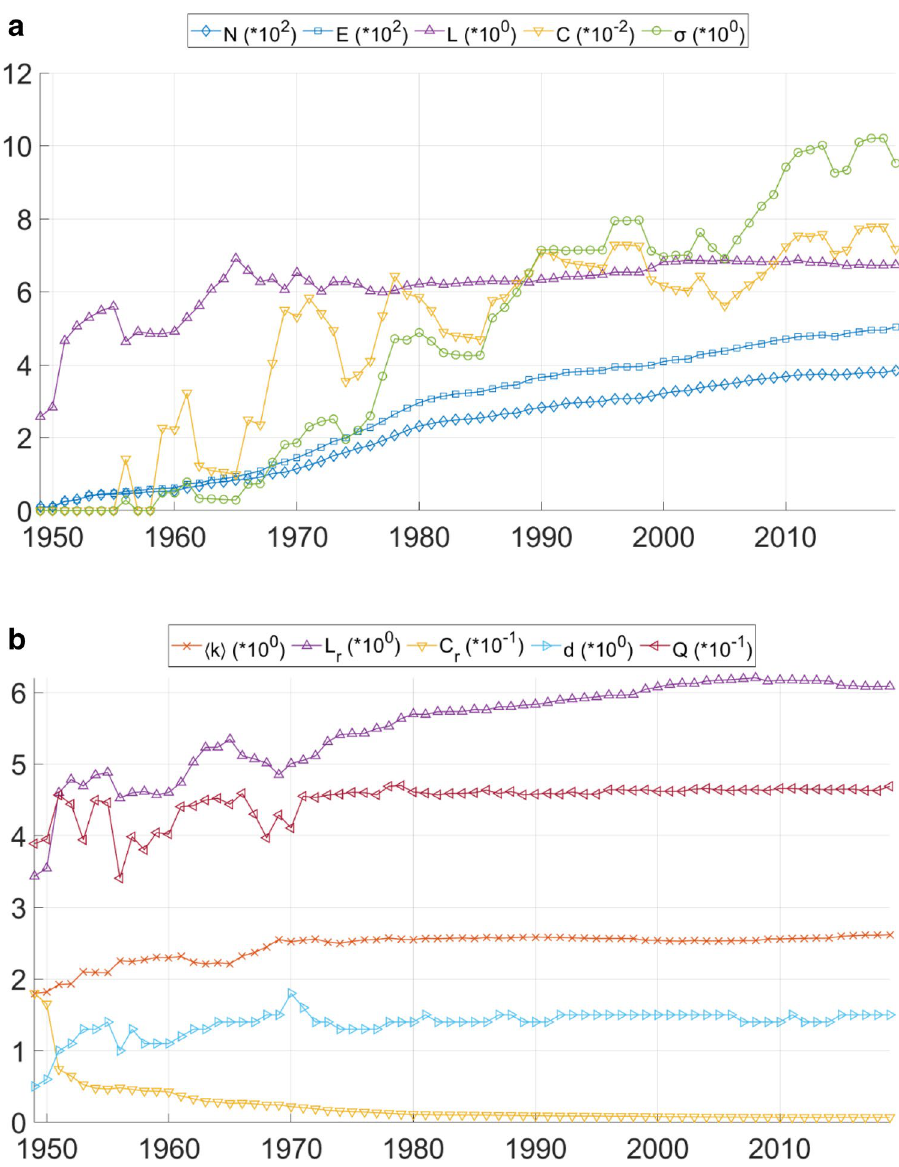
Figure 1. ( a ) Results of the long-term complex network analysis. N nodes, E edges , L average path length, C clustering coefficient, σ small-world coefficient. ( b ) Results of the long-term complex network analysis. k average node degree, L r average path length of random network, C r clustering coefficient of random network, d diameter, Q modularity